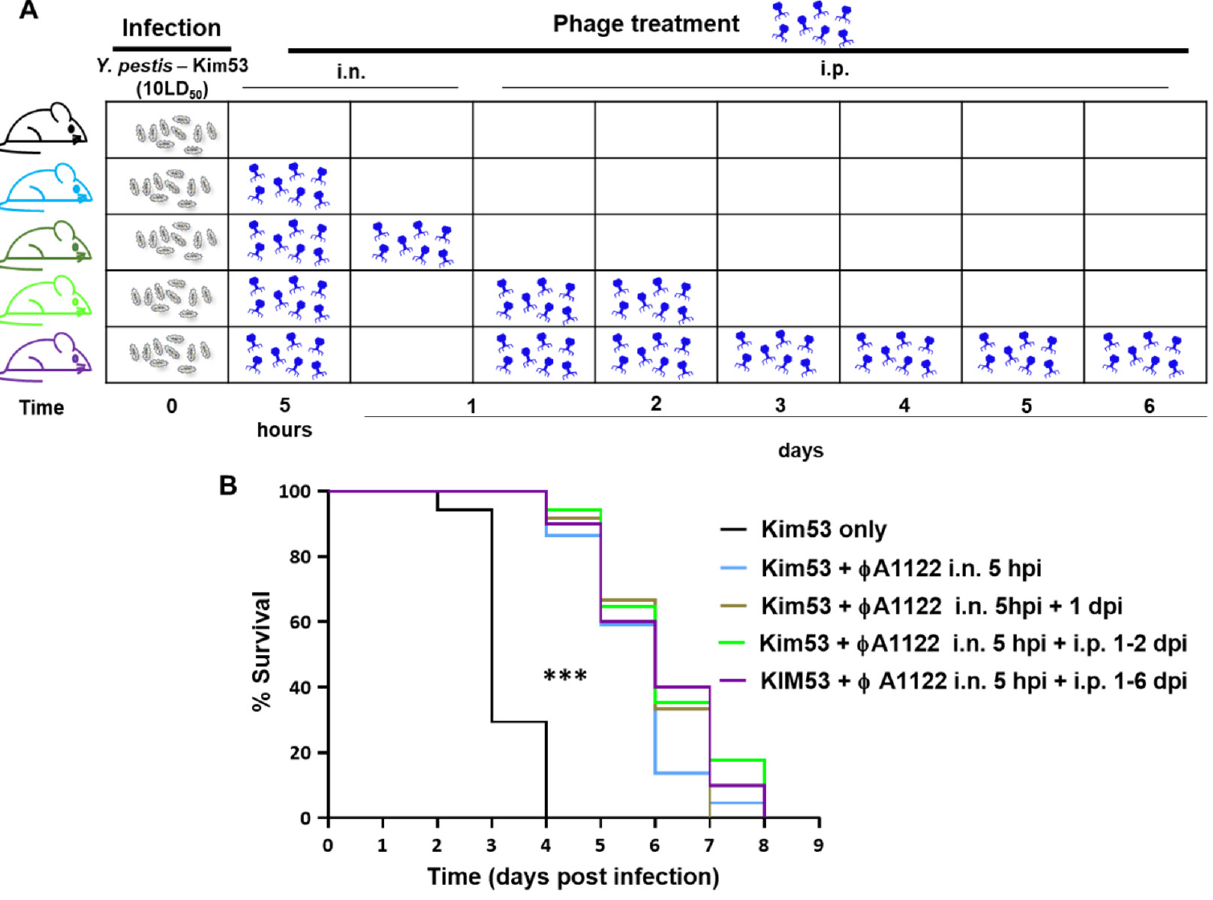
Figure 3. Multiple-dose ф A1122 phage treatments did not improve treatment efficacy. Schematic representation of mouse treatment regimens ( A ) and survival curves ( B ). C57BL/6J mice were IN infected with 10 × LD 50 of Y. pestis Kim53. For IN phage treatment, mice were inoculated with 35 µL of 1 × 10 9 ф A1122 PFU; IP injection included the administration of 0.5 mL of 1 × 10 9 ф A1122 PFU. The treatment regimens were as follows: one dose of IN ф A1122 at 5 hpi (n = 22; light blue line), two doses of IN ф A1122 at 5 hpi and 24 hpi (n = 12, olive green line), one dose of IN ф A1122